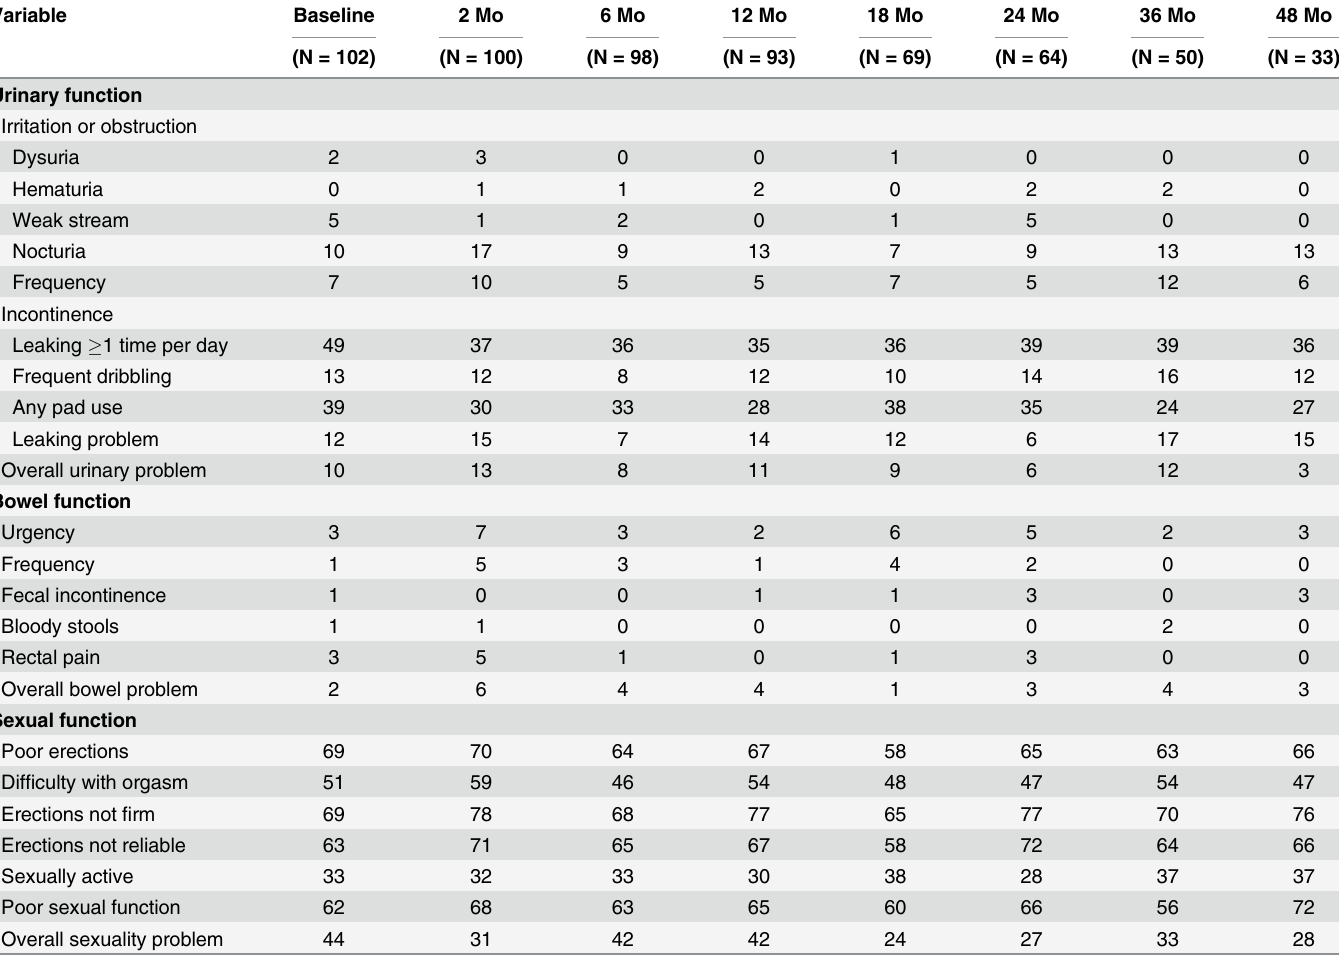
Table 2. Percent of patients reporting specific levels of dysfunction or distress for each QOL